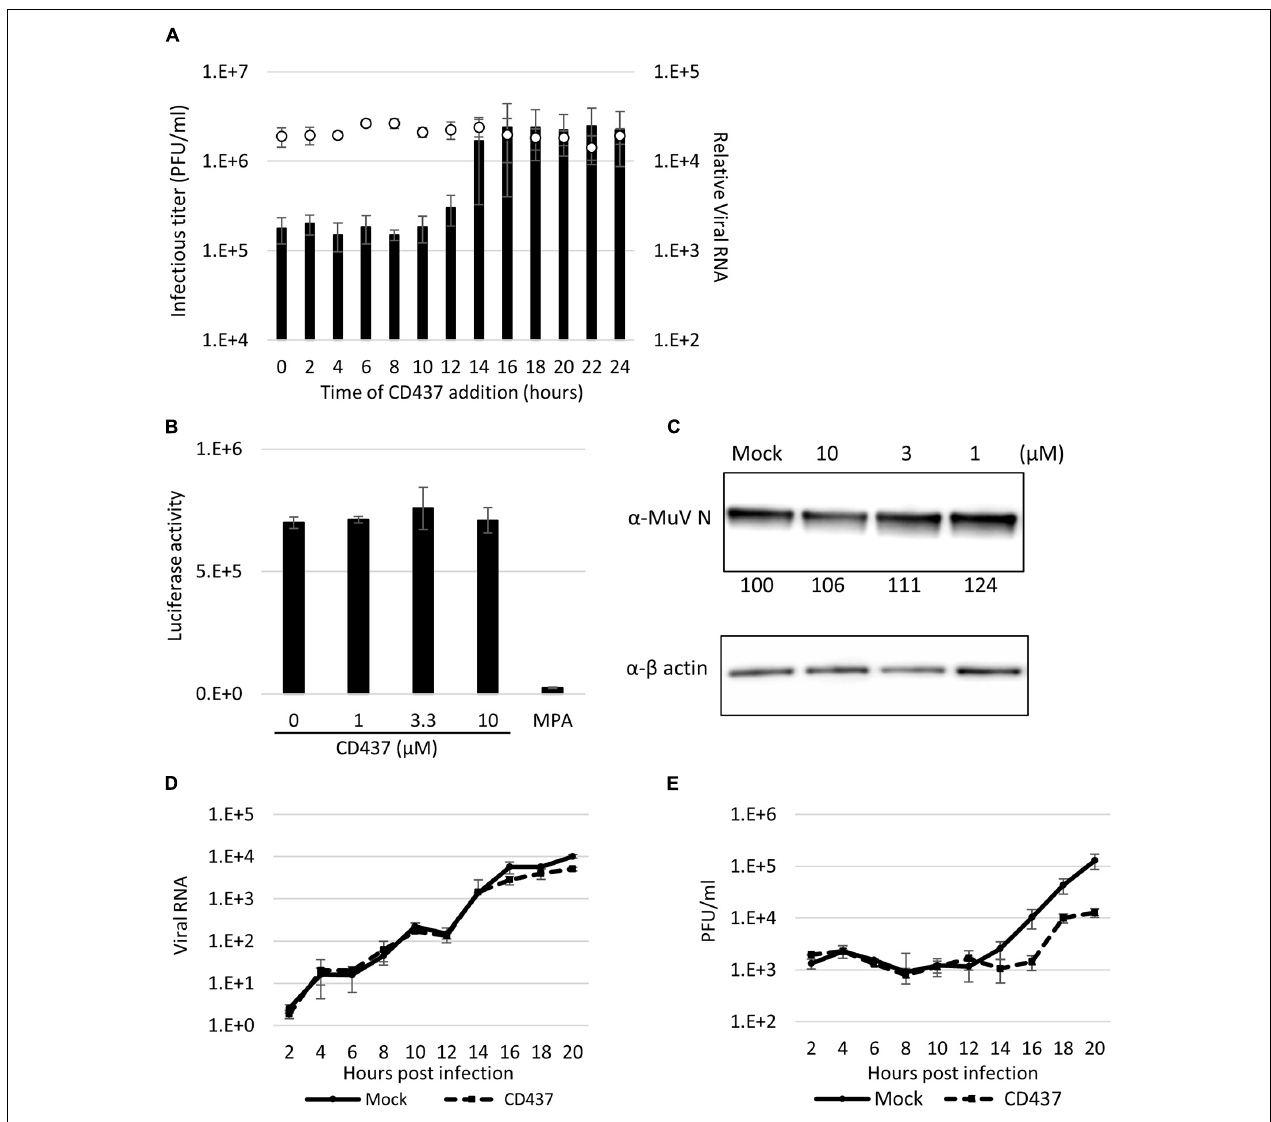
FIGURE 5 | CD437 inhibited a late step in the MuV life cycle. (A) Time-of-addition assay. A total of 10 µ M of CD437 was co-cultured with AcGFP-MuV at MOI of 2 in IFNAR1-KO A549/hSLAM cells. The left vertical axis and bar indicate the infectious titer in the supernatant 24 h post-infection. The right vertical axis and white circle indicate the intracellular RNA expression. (B) Minigenome assay. N, P, and L of MuV protein expression vector and luciferase coding minigenome plasmid were transfected into IFNAR1-KO A549/hSLAM cells and co-cultured with 10 µ M of CD437. The luciferase activities were measured at 48 h post-transfection. (C) Detection of MuV N protein with or without CD437 treatment at 24 h post-infection. IFNAR1-KO A549/hSLAM cells were cultured with 10 µ M or mock medium and infected with MuV at MOI of 2. Western blotting was performed and the band density was measured. (D) One-step growth curve of viral RNA in